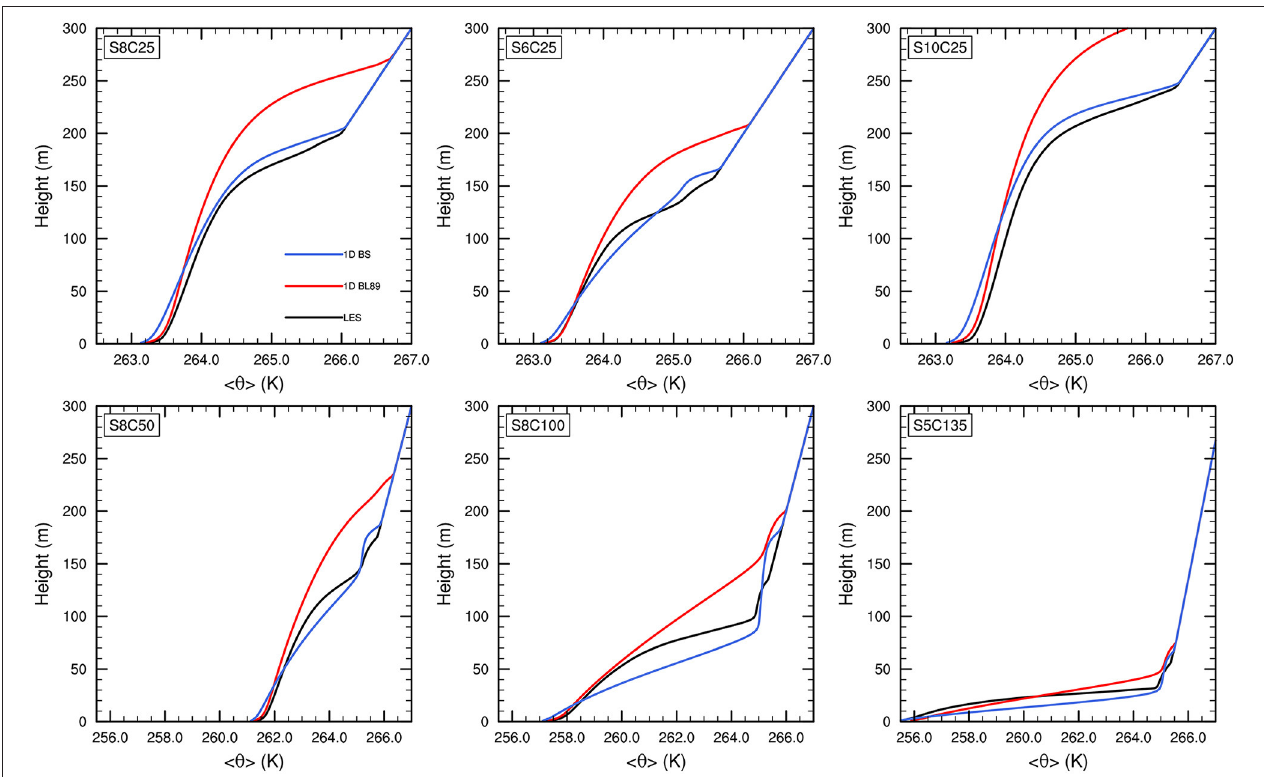
FIGURE 6 | Potential temperature profiles averaged over the final hour (8–9thh) for the stably stratified cases (S8C25, S8C50, S8C100, S5C135, S6C25, and S10C25; see Table 1 ) for the LESs (black), the SCMs with the BL89 length (red), and the SCMs with the BS length (blue).